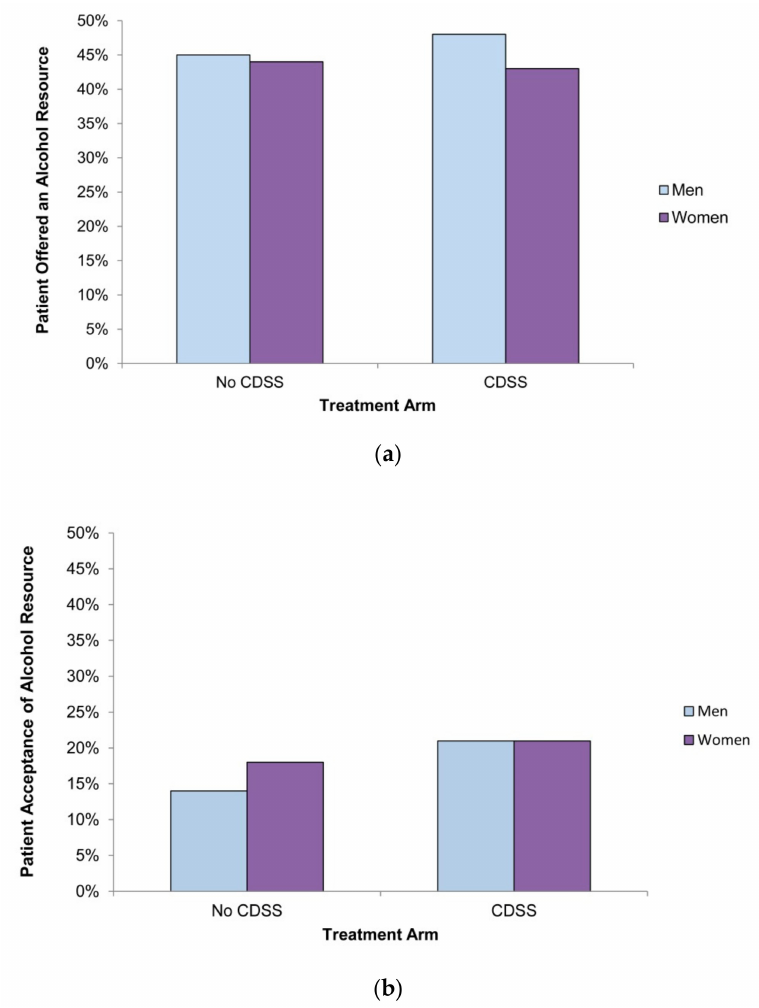
Figure 1. Proportion of men and women exceeding safe drinking guidelines ( a ) that were o ff ered an appropriate educational alcohol resource by their health care provider in each treatment arm; ( b ) that accepted the o ff er of an educational alcohol resource by their health care provider in each treatment arm. CDSS = clinical decision support